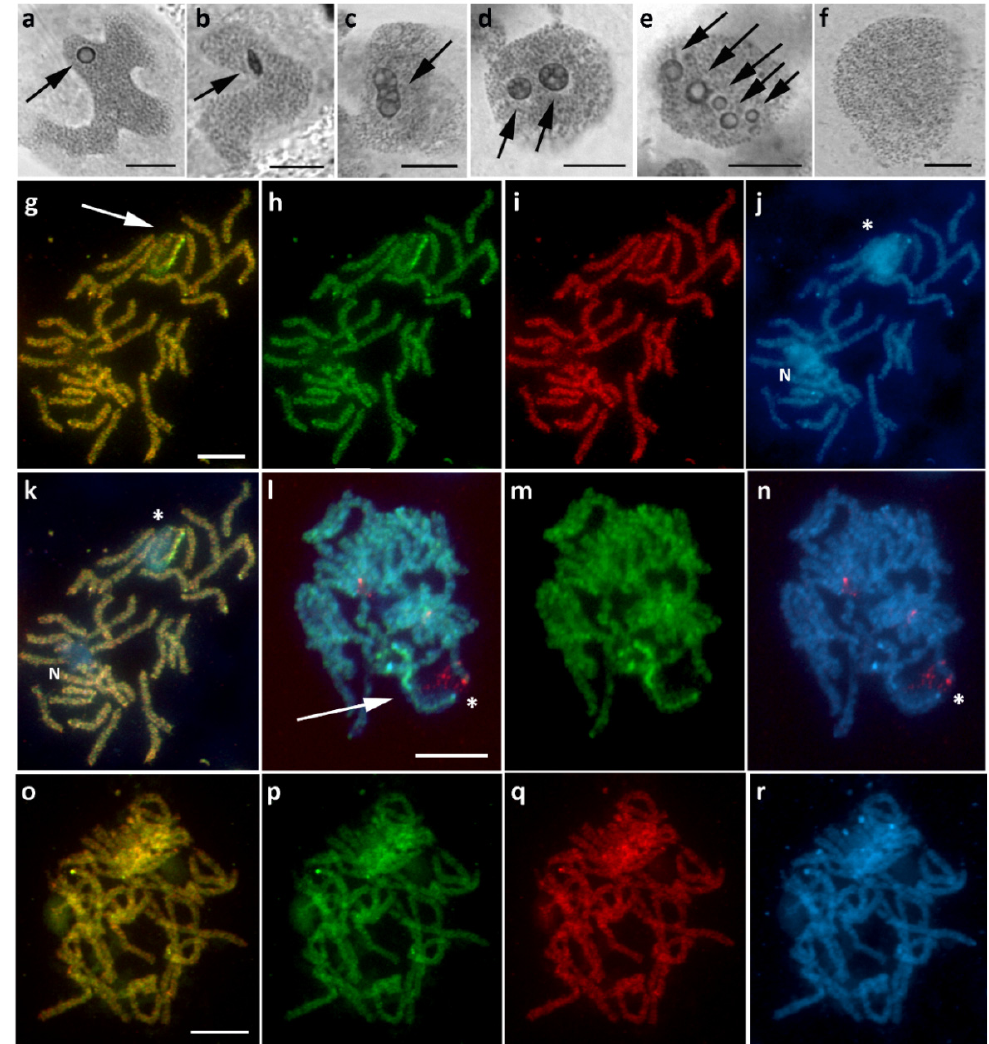
Figure 5. Multiple sex chromatin bodies and nucleolus-associated W chromosome in Hylaea fasciaria . ( a – f ) Polyploid nuclei stained with orcein showing variable forms of sex chromatin in females (( a – e ), arrows), from a regular single body or deformed body to multiple bodies, while it was absent in males ( f ). ( g – k ) CGH on female pachytene chromosomes identified a WZ bivalent (( g ), arrow), in which the strongly heterochromatinized part of the W chromosome was preferentially labeled with the female genomic probe ( g – i ), and the other part of the WZ bivalent was associated with the nucleolus, well visible after DAPI staining (( j , k ); asterisk); note the second nucleolus (N) in the same pachytene complement ( j , k ). ( l–n ) GISH combined with FISH with 18S rDNA probe on female pachytene chromosomes identified the WZ bivalent (( l ), arrow) according to the W chromosome labeled by the female genomic probe ( l , m ) and the associated nucleolus by scattered signals of the 18S rDNA probe ( l , n ; red signals, asterisk). ( o – r ) CGH on male pachytene chromosomes without any differentiated region. Panels ( g , o )—merged pictures of both genomic probes; ( h , m , p )—female genomic probe (green); ( i , q )—male genomic probe (red); ( j , r )—DAPI staining (light blue); ( k )— merged picture of both genomic probes and DAPI staining; ( l )—merged picture of the female genomic probe, 18S rDNA probe, and DAPI staining; ( n )—merged picture of 18S rDNA probe and DAPI staining. Bar = 10 µ